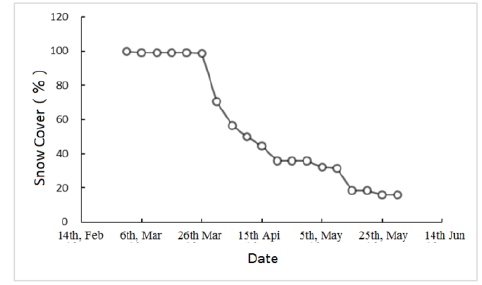
Figure 5. Snow cover changes in spring 2017 in the study area